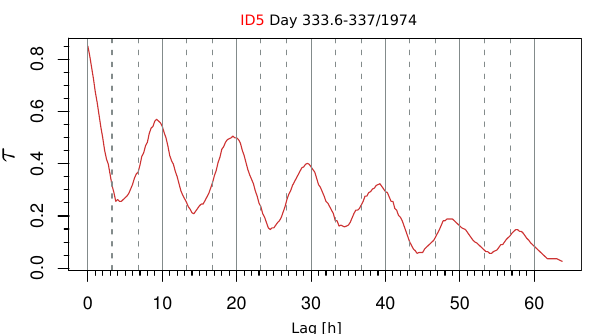
333.5 to 336.5 in 1974, showing the same quantities as Fig. 7. Com-